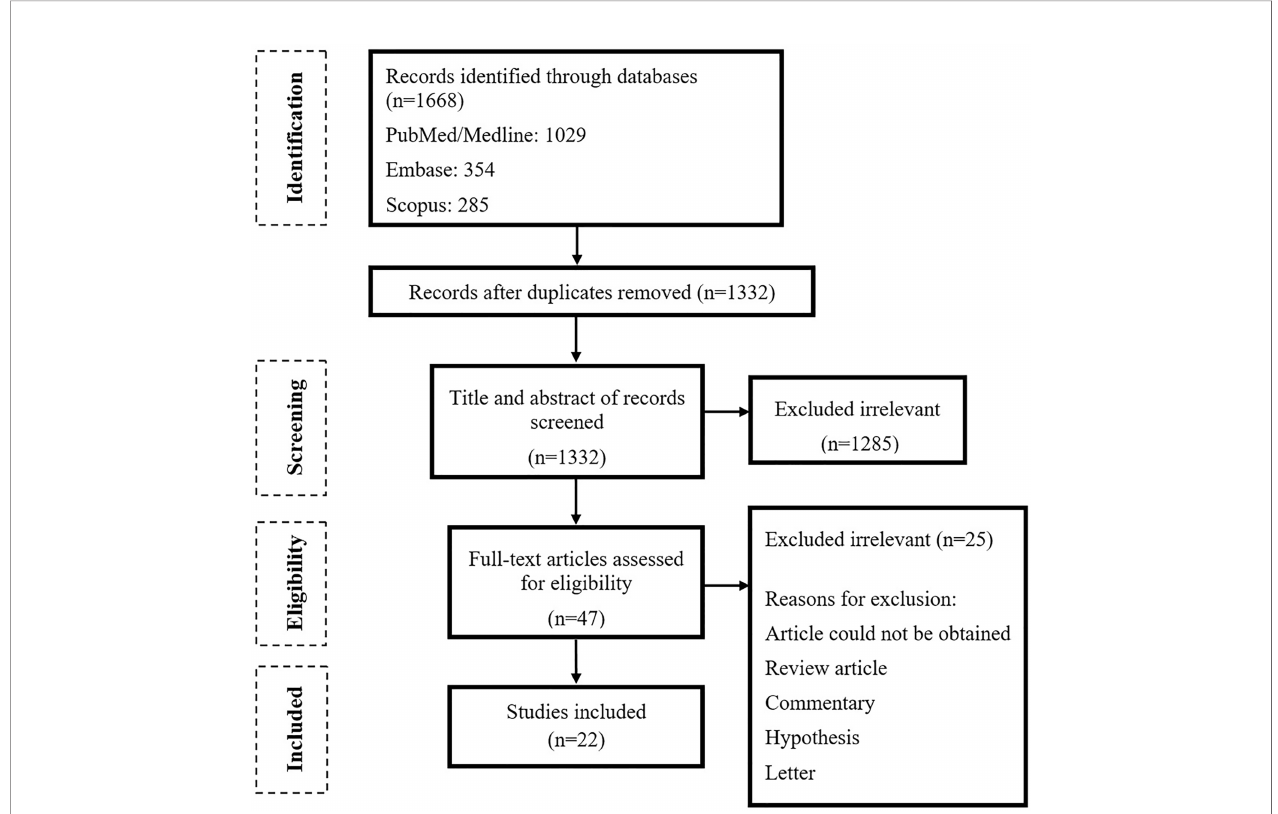
FIGURE 1 | PRISMA fl owchart of study selection for inclusion in the systematic